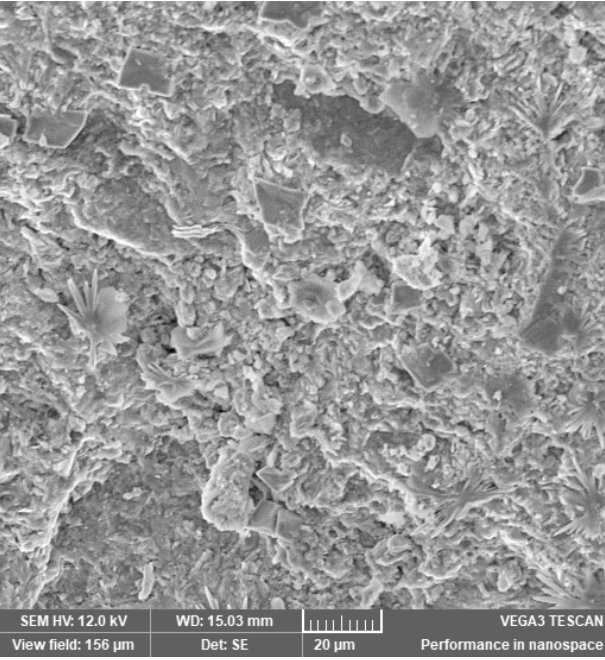
Figure 6. The SEM analysis of the zeolite sample NaOH 2.